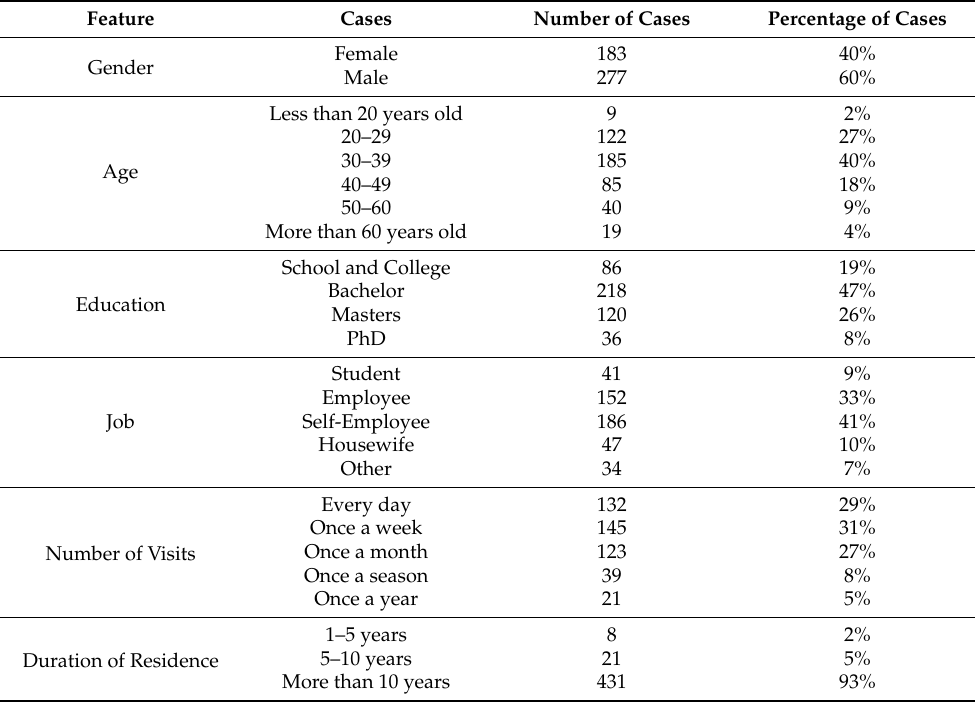
Table 3. The sociodemographic status of participants who answered the